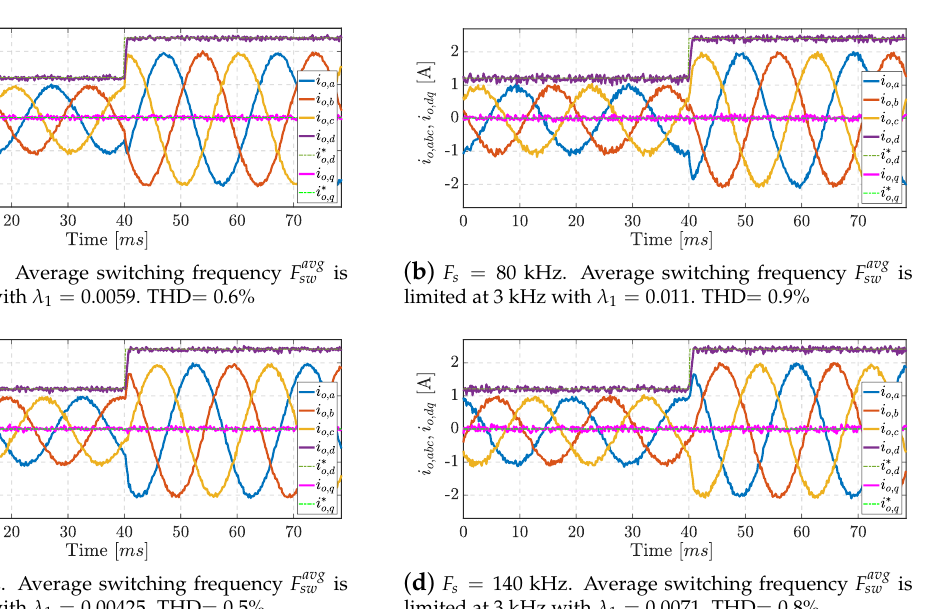
Figure 9. Experimental results at sampling frequency F s = 40 kHz: Output currents in abc and dq-frame. At t = 40 ms, the reference amplitude for the abc-frame current changes from 1 A to 2 A.